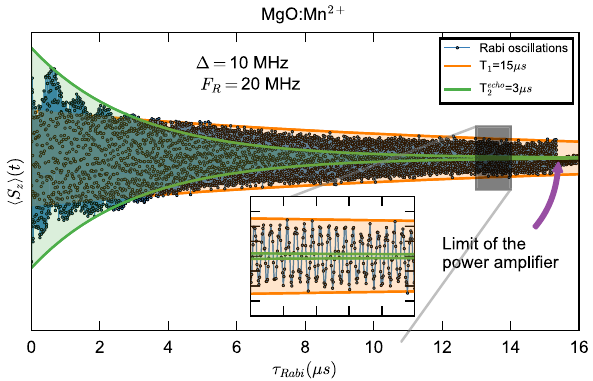
Figure 2. Rabi decay under image pumping condition at 40 K. The decay of the Rabi oscillations (green) for a Mn 2 + spin is limited by the relaxation time T 1 (orange) when an image pulse is used to sustain the dynamics. the